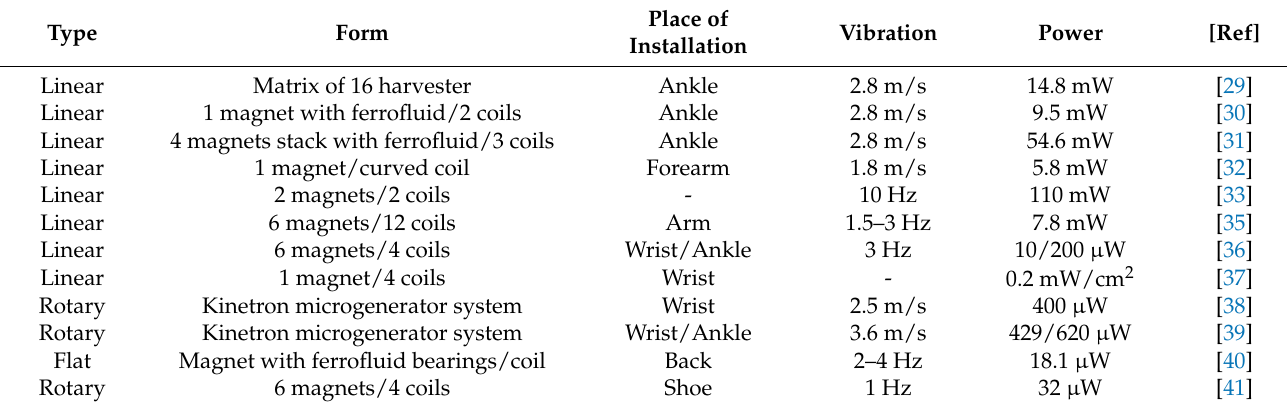
On Table 4 we present a comparison of electromagnetic harvesters with base parameters. Table 4. Comparison electromagnetic